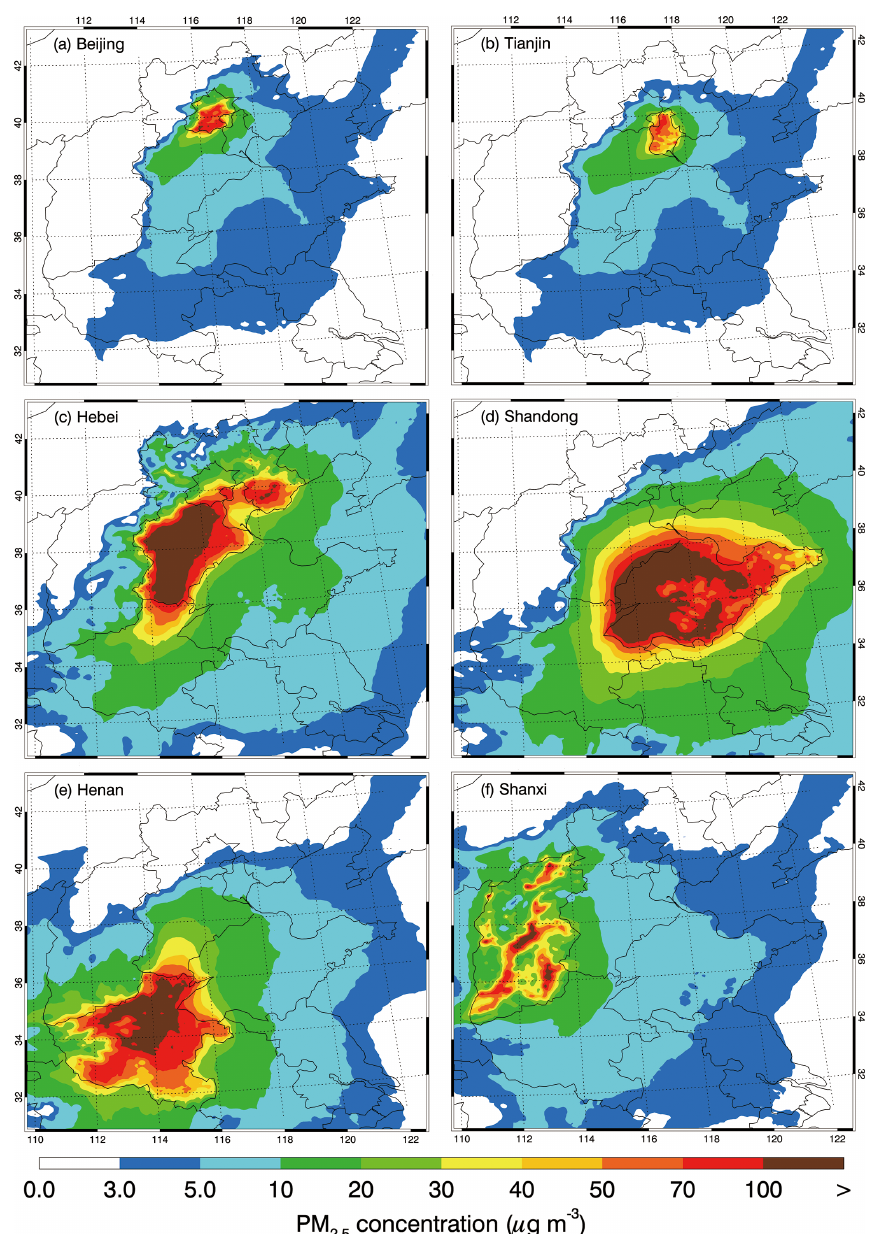
Figure 5. Spatial distribution of average PM 2 . 5 contributions from (a) Beijing, (b) Tianjin, (c) Hebei, (d) Shandong, (e) Henan, and (f) Shanxi provinces from 5 December 2015 to 4 January